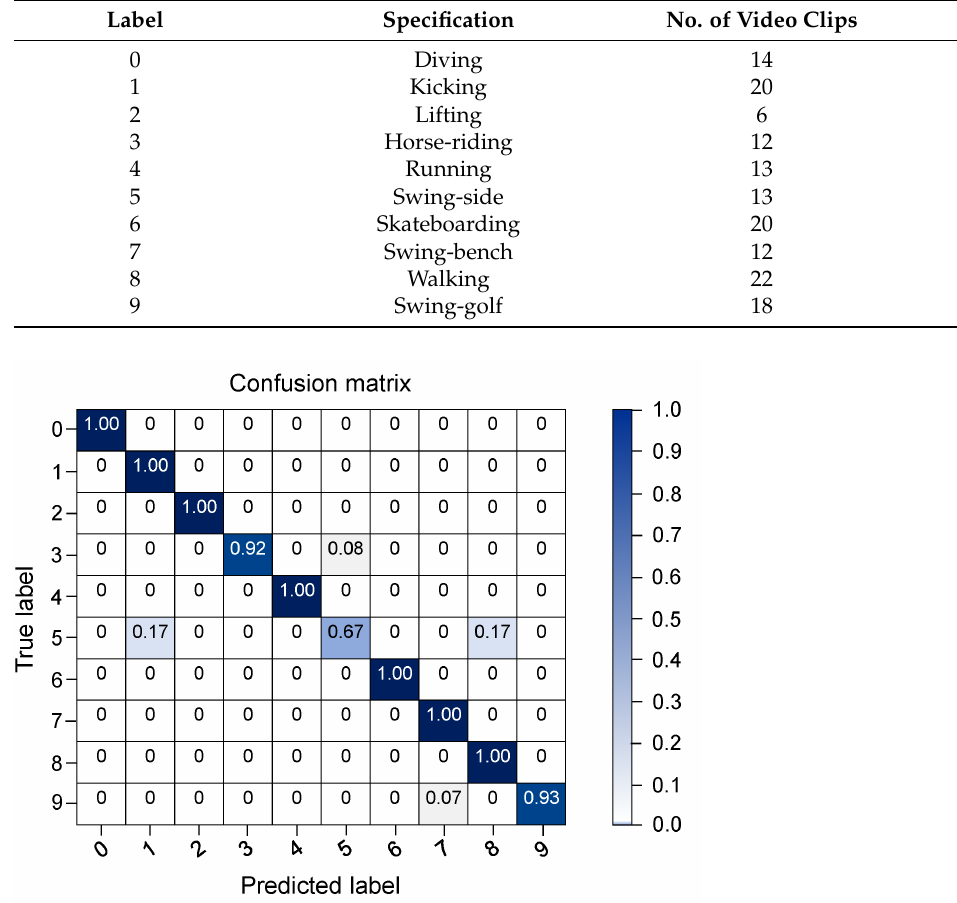
Table 1. Description of the different labels used in Figure 8.